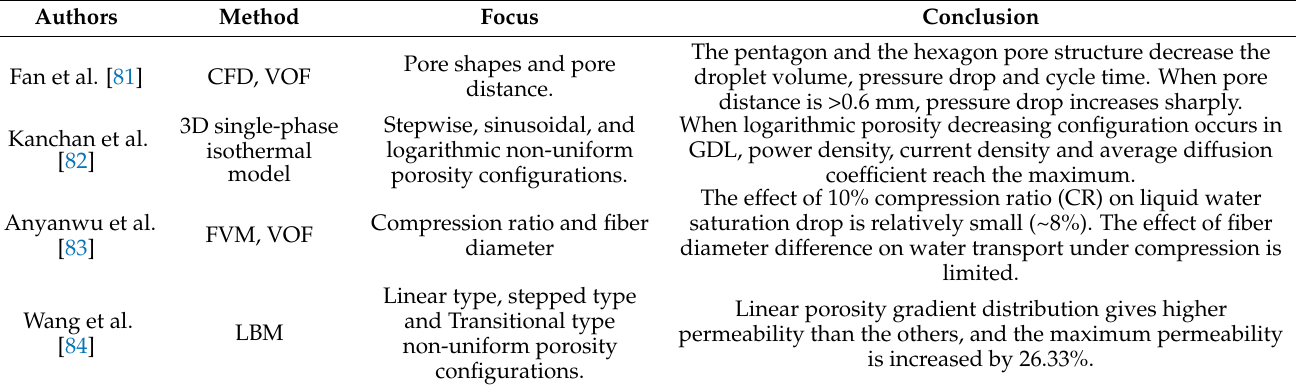
Figure 8. Schematic of the hydrophobic treatments of the GDL samples with ( a ) immersion and ( b ) hydrothermal methods. Reproduced with permission [80]. Copyright 2021, Elsevier. Table 1. Summary of recent theoretical results using the methods of computational fluid dynam- ics (CFD), volume of fluid (VOF), finite volume (FVM), lattice Boltzmann (LBM) and pore-scale model